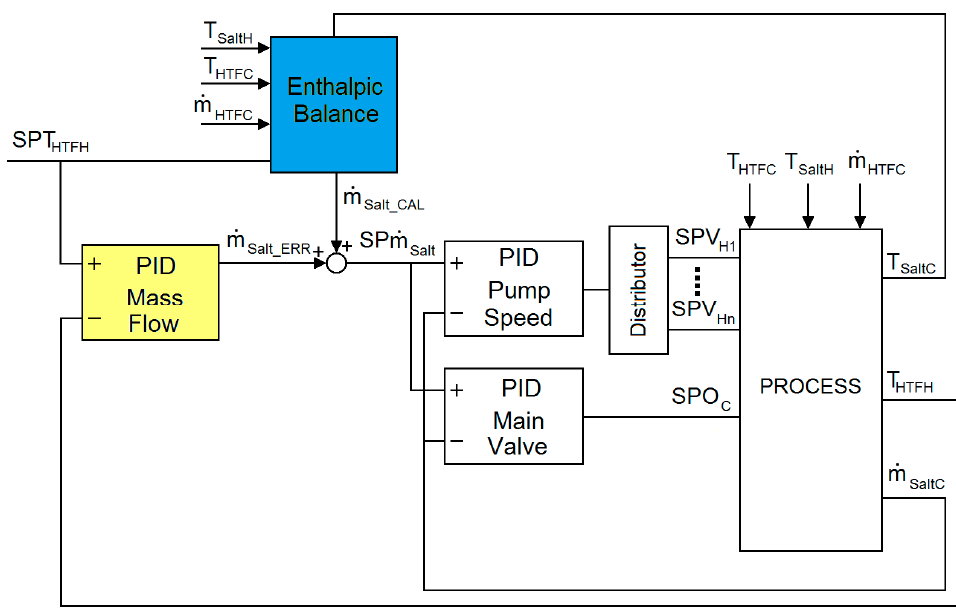
Figure 5. PID control with feed-forward (discharge process).